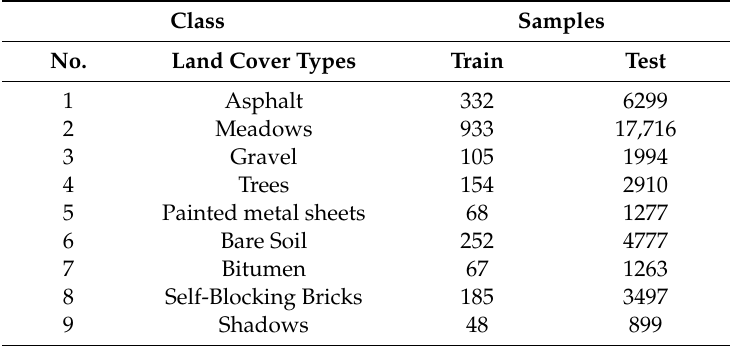
Figure 11. Pavia University dataset. ( a ) False color image composite (band 50, 27 and 17); ( b ) ground truth image. Table 10. Land cover classes and the number of samples for Pavia University dataset.